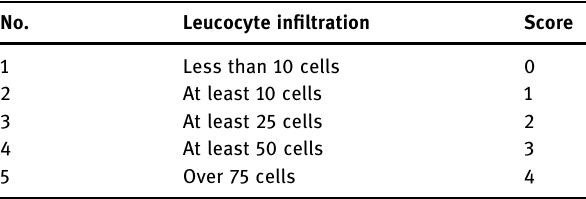
Table 1: Histopathological lung leucocyte in fi ltration according